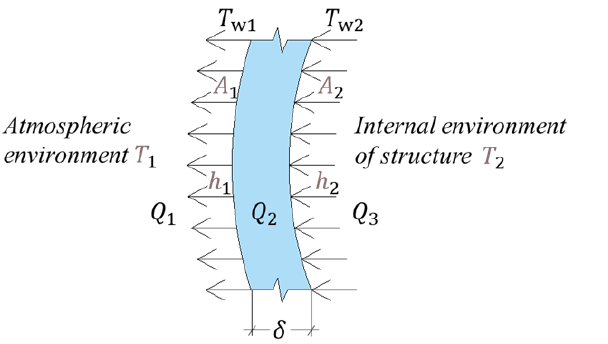
Figure 1. Illustration of heat transfer in a TPC. (The arrow direction is the temperature transmis- sion direction)